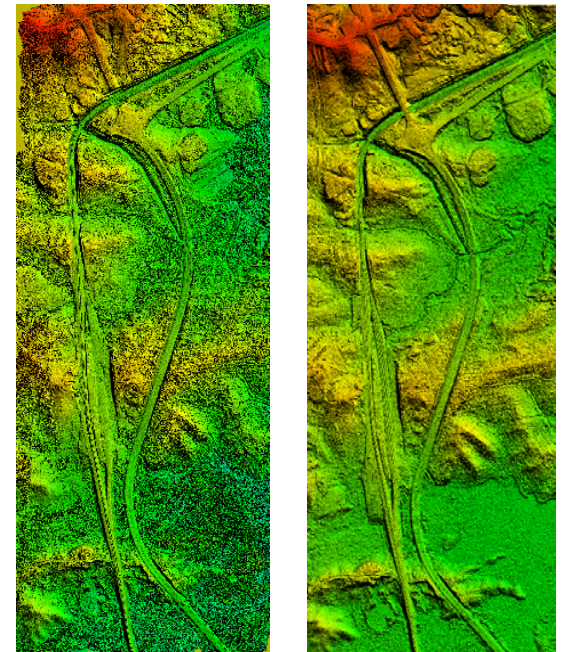
Figure 2. DEM from non-metric digital camera on UAS on left, DEM from LIDAR on right